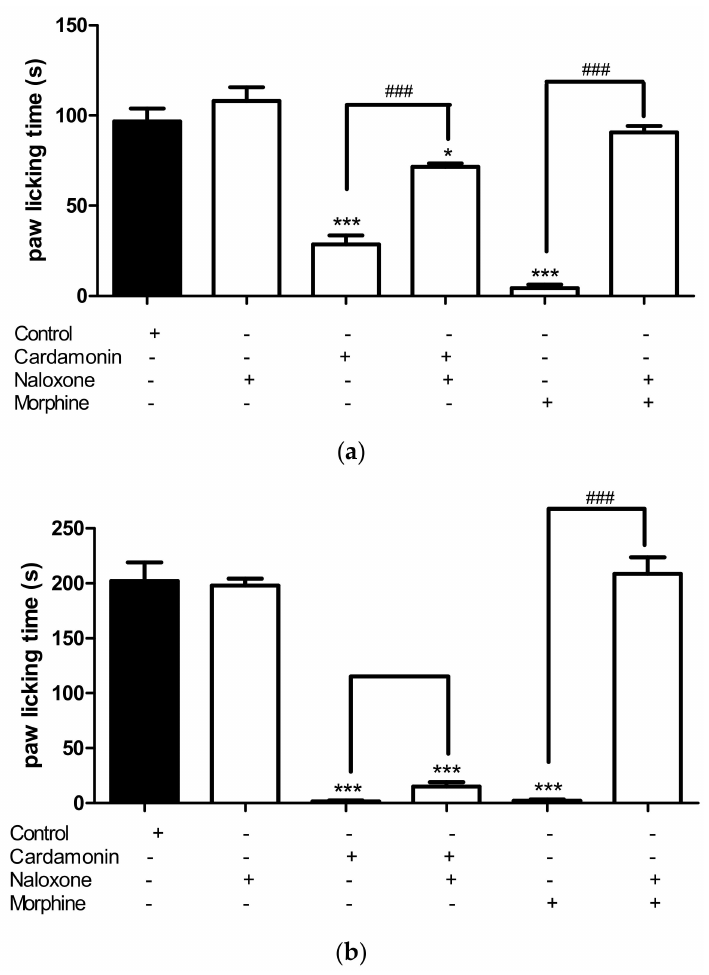
Figure 5. ( a ) Effect of naloxone (5 mg/kg, i.p.) on antinociception caused by cardamonin (1